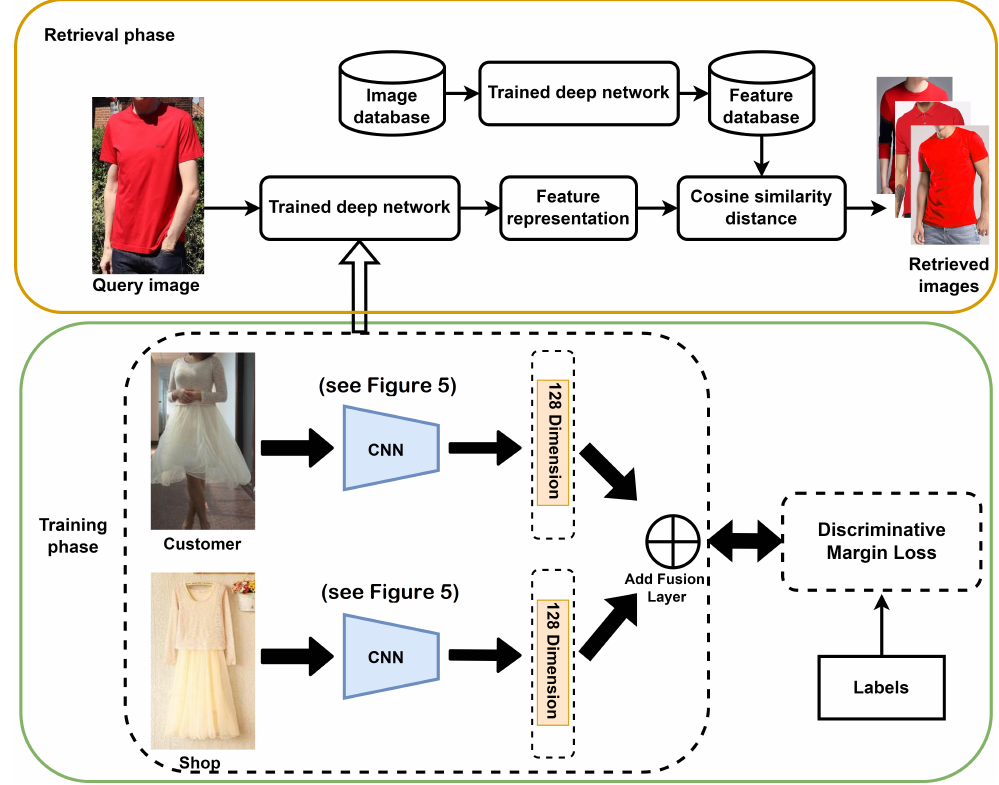
Figure 4. The overview of our proposed cross-domain consumer-to-shop clothes retrieval system. The Siamese network consists of two subnetworks with the same architecture and weights. The extracted features of the two subnetworks are normalized by L 2 normalization. The two 128-dimensional embedding instances for customer and shop images are merged by Add fusion layer. The DML loss drives the training of the network to learn features where the discriminative decision boundary increases and the negative margin becomes more compact. Then, the trained deep network is used to extract features from the image database and create a feature database. In the retrieval phase, features of the query image are extracted by the trained deep network and compared with the features of the feature database by the cosine similarity distance. Finally, top ranked results are displayed to the customer.